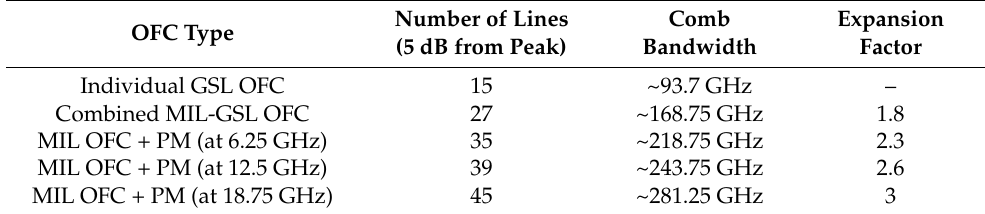
Table 2. Summary of the OFC expansion at FSR of 6.25 GHz.